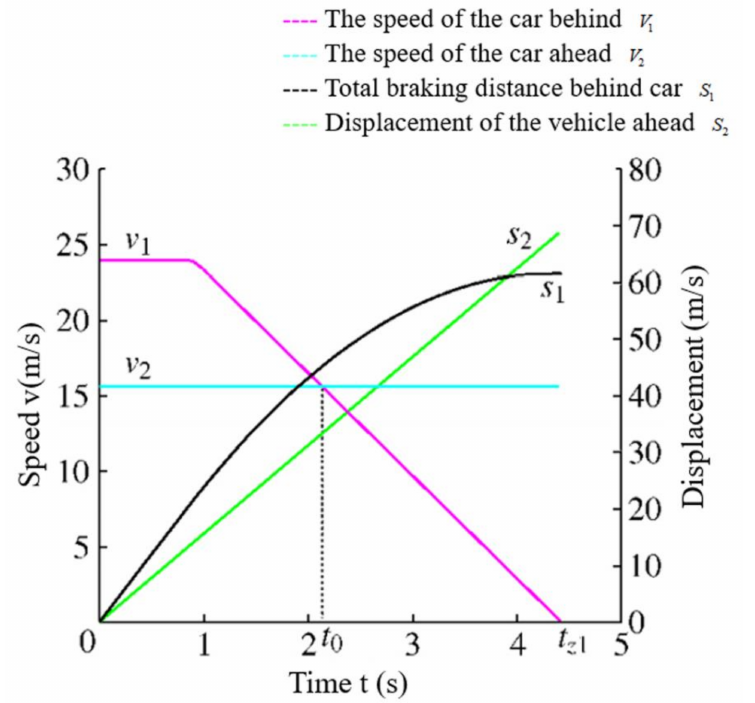
Figure 15. Velocity—displacement variation